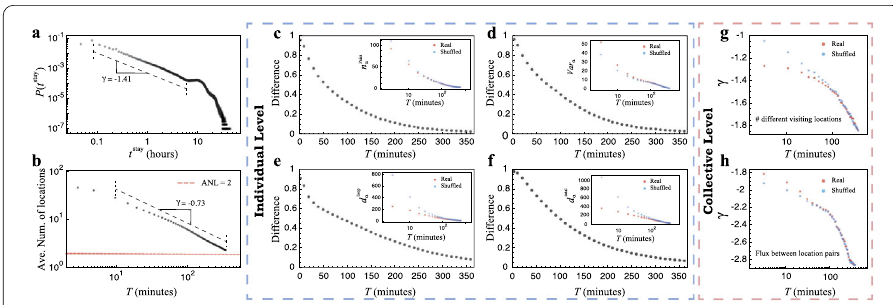
Figure 2 The dependence of mobility statistical properties on the data temporal resolution. ( a ) Distribution P ( t stay ) of the duration t stay of a stay at each location for all users. We then conduct the statistics below by removing the visited locations with t stay for all users. ( b ) The average number of visited locations as a function of T . In fact, the threshold T can be regarded as a parameter controlling the resolution of the data. A larger threshold T identifies less visited locations, and thus corresponds to a poorer data resolution. ( c - f ) The difference between the real data and the shuffled data in terms of ( c ) the total transited location pairs n pairs α , ( d ) the variance Var α of the traveled frequency of location pairs, ( e ) the covered distance d loop α of the maximum loop, ( f ) the total traveled distance d total α , as a function of threshold T . The insets in each figure show the mean values of the corresponding metric under different threshold. The power-law exponents γ of the distributions of ( g ) the number of neighboring locations from each location, and ( h ) population flux between each two locations, in the real data and the shuffled data as a function of threshold T . In both ( g ) and ( h ), there is large difference between the exponents of the real and the shuffled data when the threshold T is small, and the difference becomes negligible when the threshold is